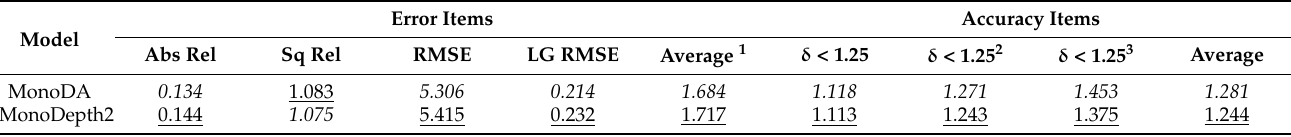
Table 3. The evaluation result of MonoDepth2 and MonoDA in vineyard scene.